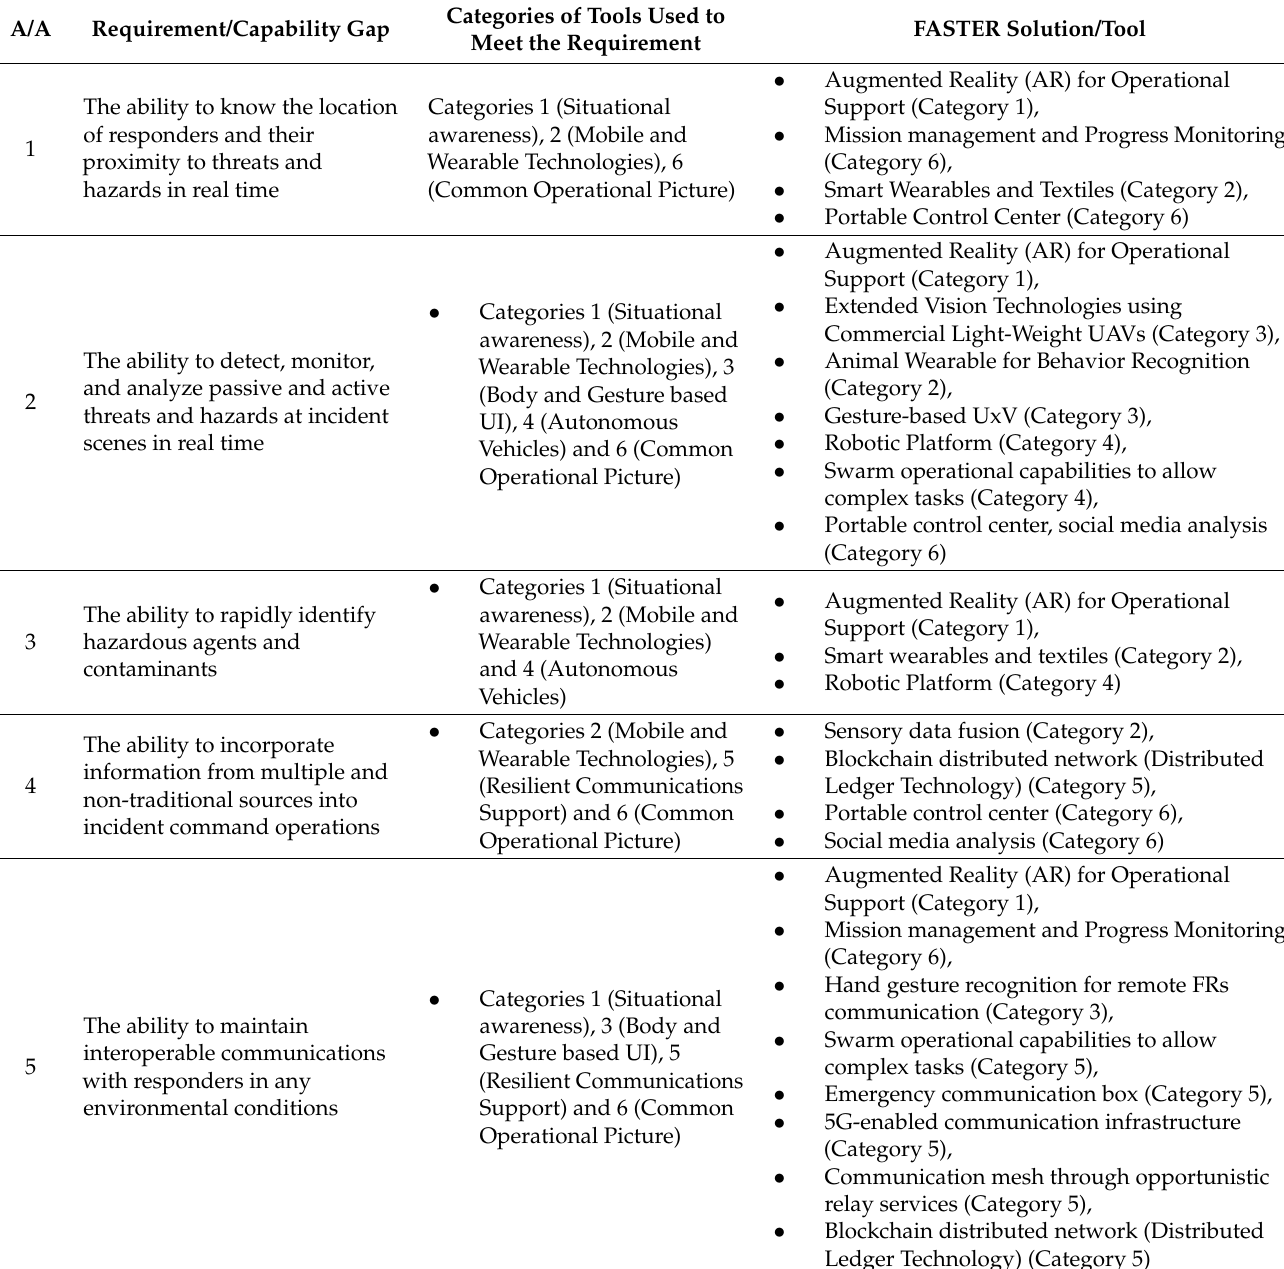
Table 1. IFAFRI communication gaps and FASTER solutions/tools for